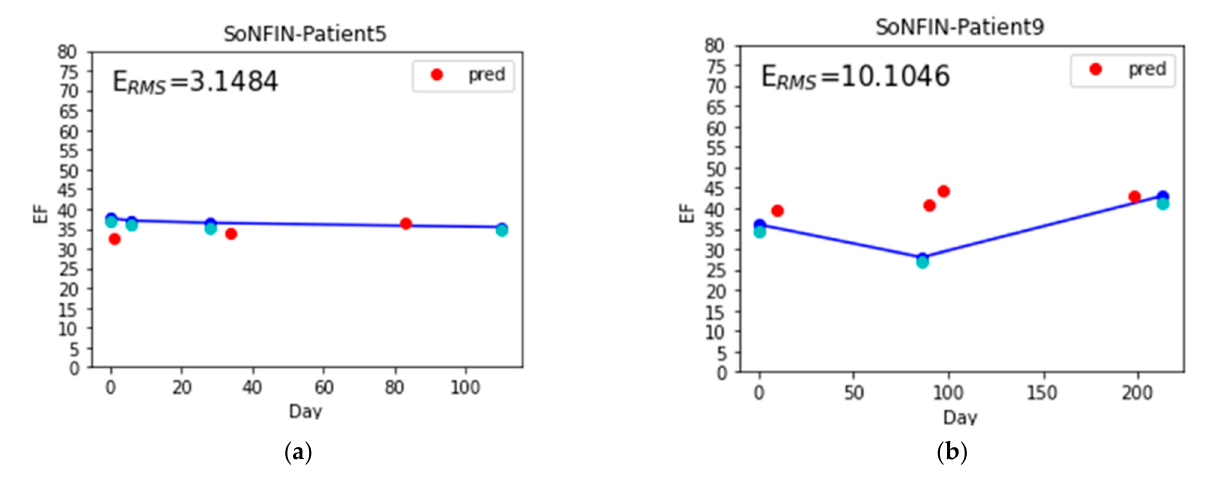
Figure 12. The estimated LVEF for the lowest and highest E RMS values by SoNFIN, the blue points are the LVEF measured by the echocardiography, green points are the estimated LVEF of training model, and red points are the estimated LVEF of the testing model, ( a ) patient 5, and ( b ) patient 9.